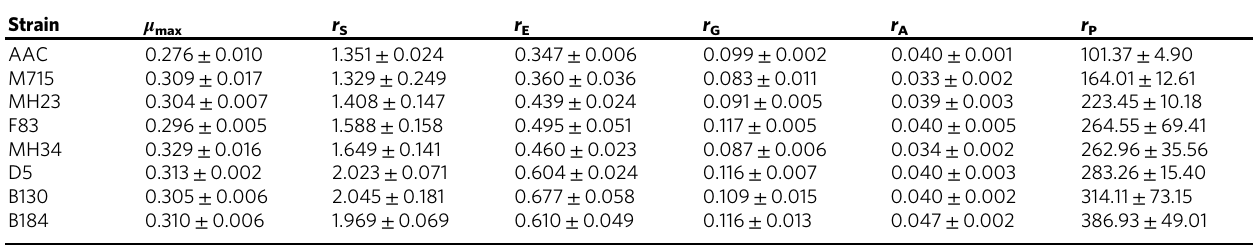
Table 1 Physiological parameters of the mutant strains